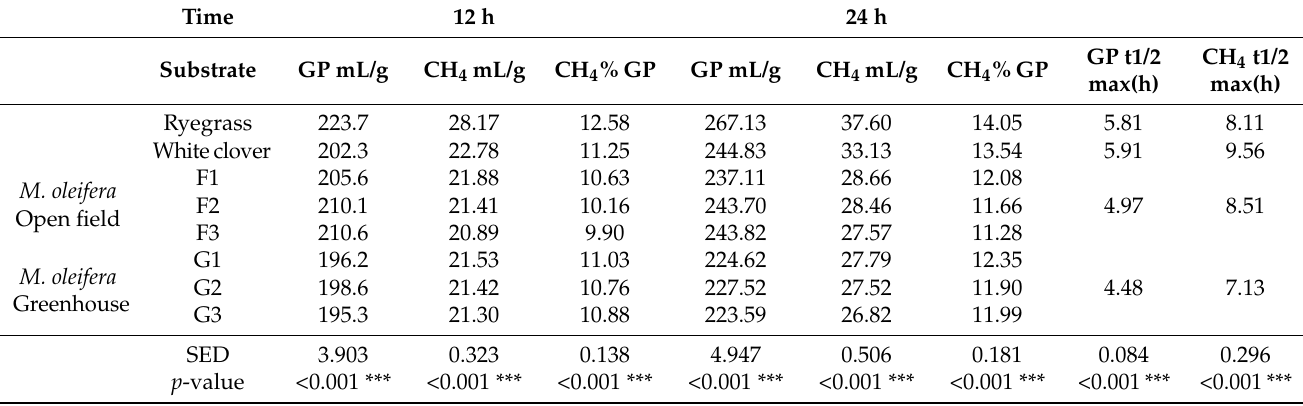
Table 3. Total gas production, methane and proportion of methane at 12 and 24 h for perennial ryegrass ( L . perenne ), white clover ( T . repens ) and M . oleifera. The average standard error of the differences of means (SED) and p -value are presented. GP t 1/2 max(h) and CH 4 t 1/2 max(h) (half for M . oleifera in open field and greenhouse are the average for F1, F2, F3 and G1, G2, G3 respectively. t 1/2 max signifies half the maximum